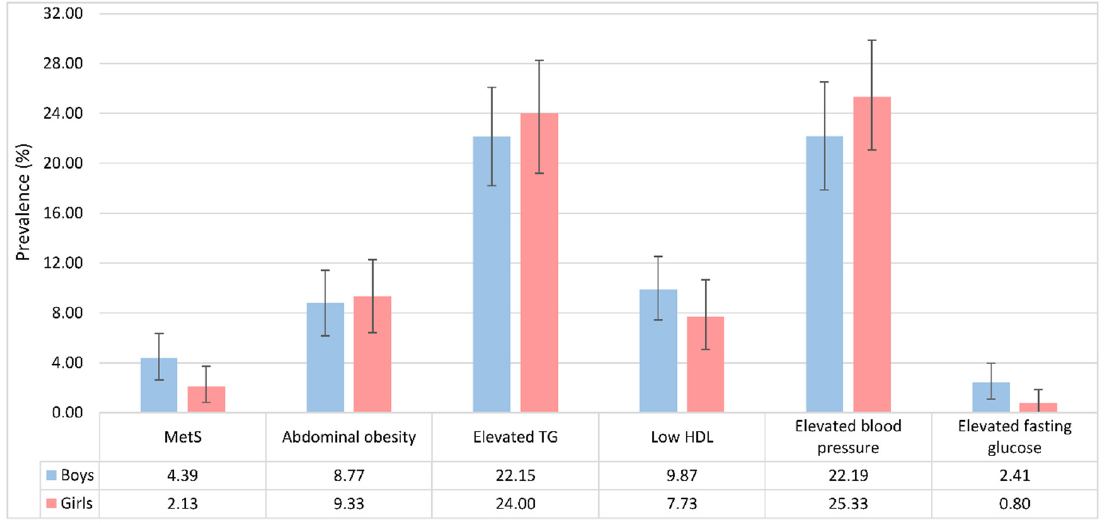
Figure 1. Gender ‐ specific prevalence of paediatric metabolic syndrome (MetS) and its components. HDL: high ‐ density lipoprotein cholesterol; TG: triglyceride.